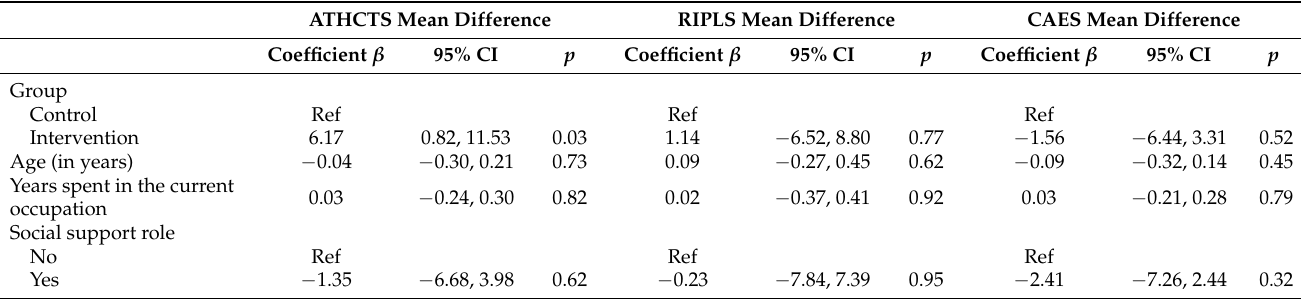
Table 3. Multivariate associations between participant characteristics and mean differences on ATHCTS, RIPLS, and CAES. ATHCTS Mean Difference RIPLS Mean Difference CAES Mean Difference Coefficient